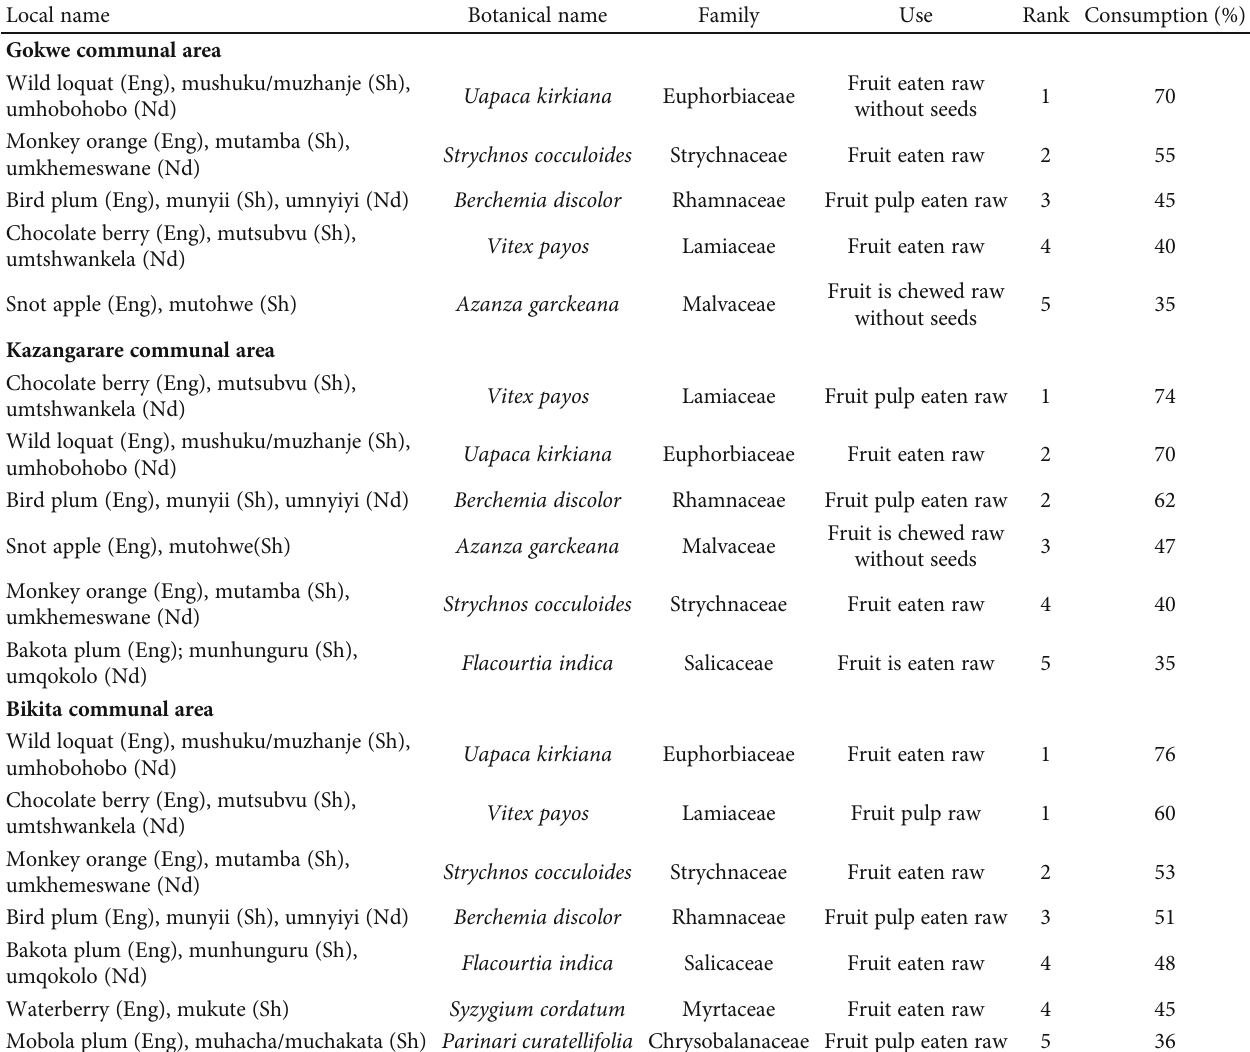
Table 1: Ranking of indigenous fruit trees (IFTs) as food resources by locals in Gokwe, Bikita, and Kazangarare, Zimbabwe. Local